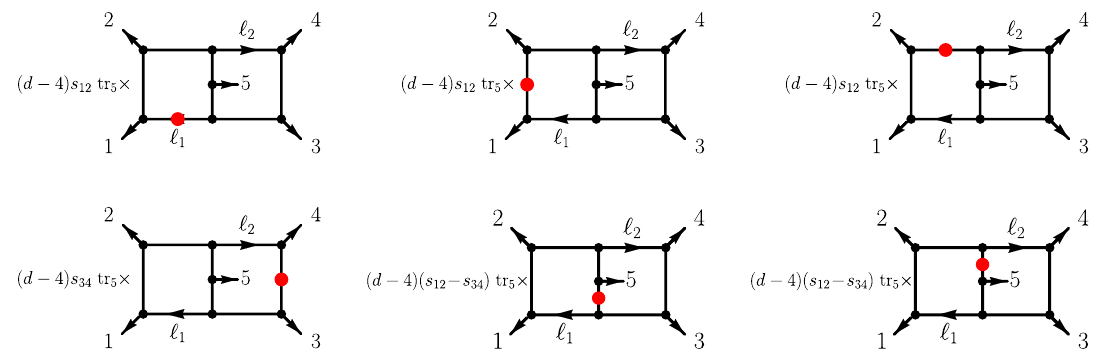
Figure 3 . The six parity-odd (6 (cid:0) 2 (cid:15) )-dimensional master integrals and their normalization factors. The integrals have no numerators. A red dot indicates that the propagator is \doubled" i.e. raised to a squared